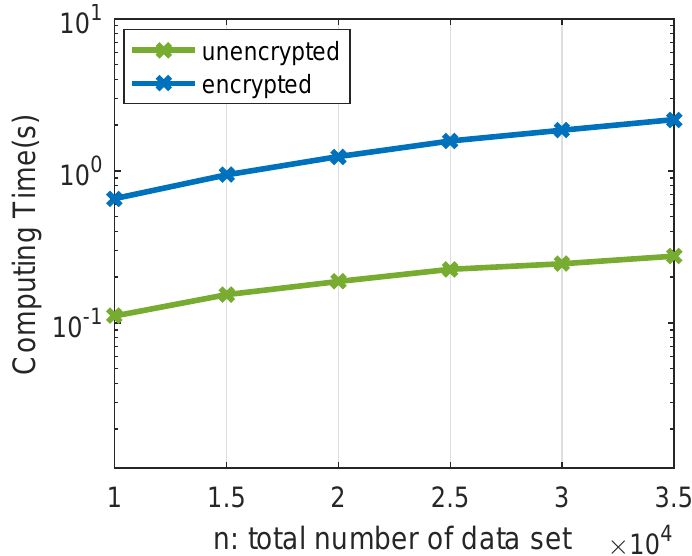
Figure 9. Computing time of the unencrypted process and that of PPDC.